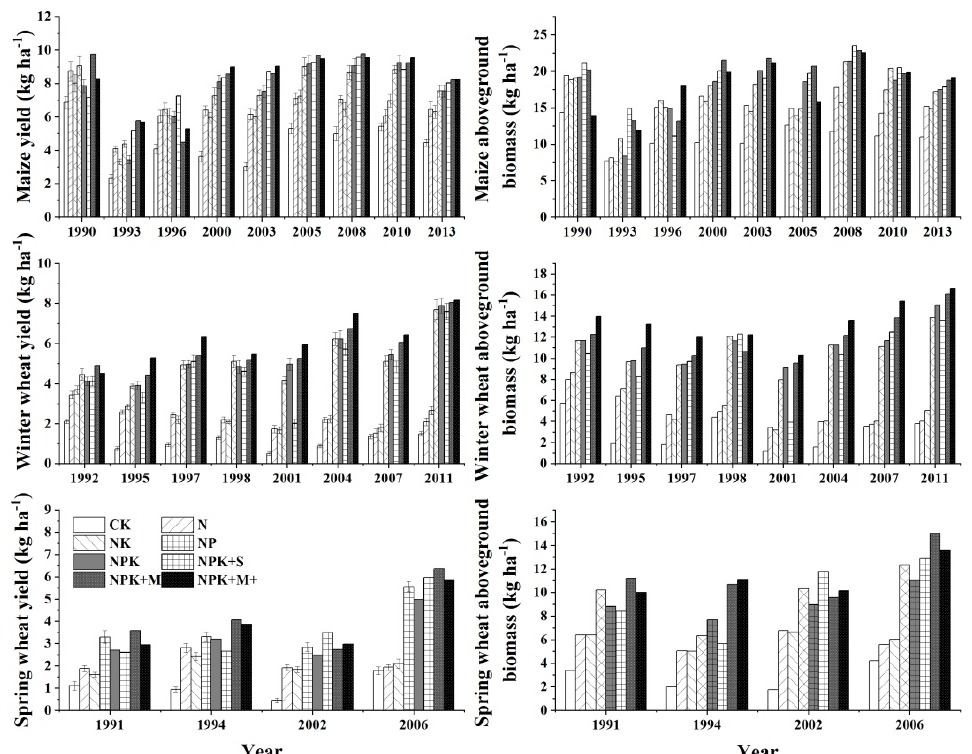
Figure 2. Effect of fertilizer treatments on crop yield and aboveground biomass under long-term fertilization in 1990–2013. Table 3. Mean yield, coefficient of variation (CV), sustainable yield index ( I sy ), and nitrogen harvest index (NHI) of spring wheat, winter wheat, and maize and the ANOVA results showing ‘Groups’ of treatments from 24 years’ data.